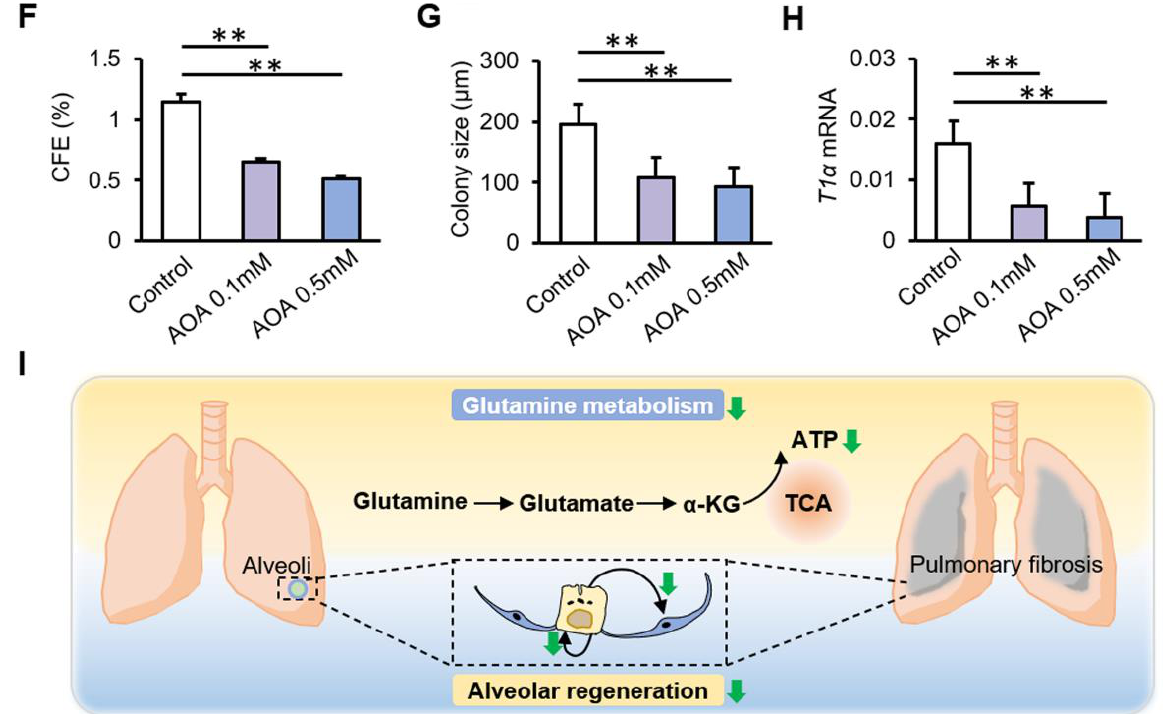
Figure 4. Inhibition of glutamine metabolism reduces the proliferation and differentiation of AT2 cells. ( A ) Representative micrographs of organoid cultures of mouse AT2 cells cultured with DON. ( B , C ) CFEs ( B ) and colony size ( C ) of organoid colonies. ( D ) T1 α mRNA expression of organoid colonies after stimulation with DON. ( E ) Representative micrographs of organoid cultures of AT2 cells cultured with AOA. ( F , G ) CFEs ( F ) and colony size ( G ) of organoid colonies. ( H ) T1 α mRNA expression of organoid colonies after stimulation with AOA. ( I ) Schematic diagram describing a possible contribution of glutamine metabolism to the proliferation and differentiation of alveolar progenitor cells. ** p < 0.01.